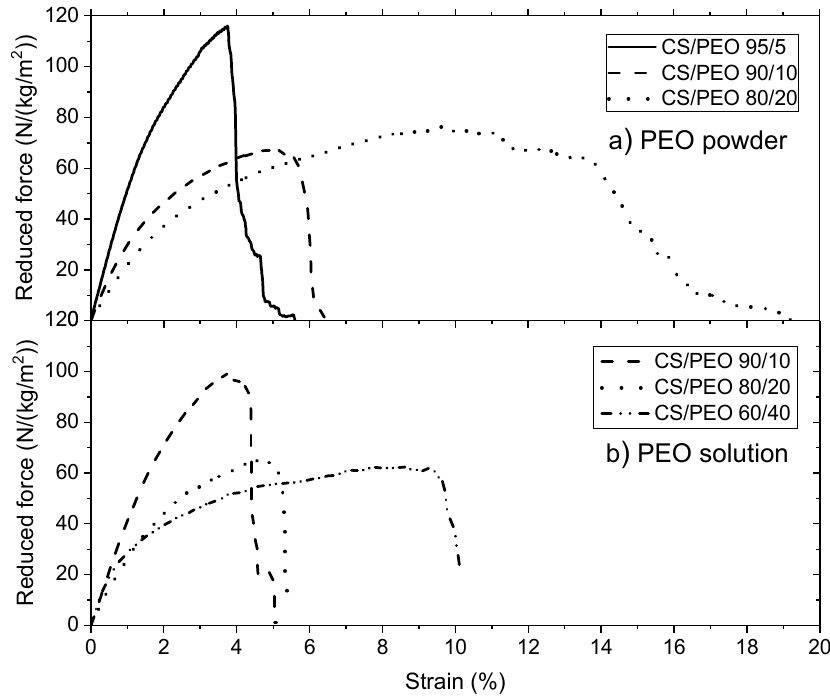
Figure 7. Uniaxial extension for chitosan/PEO nanofibers blends in the initial state. ( a ) PEO M W = 5 × 10 6 added under powder form; ( b ) PEO mixed in solution from M W = 5 × 10 6 at 3%.